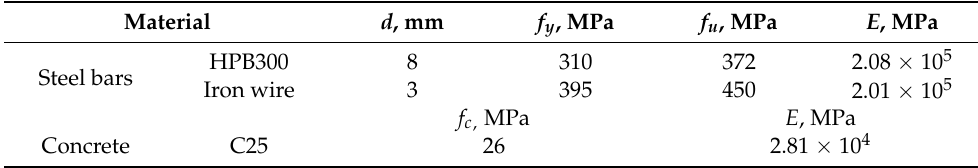
Table 1. Properties of steel bars and